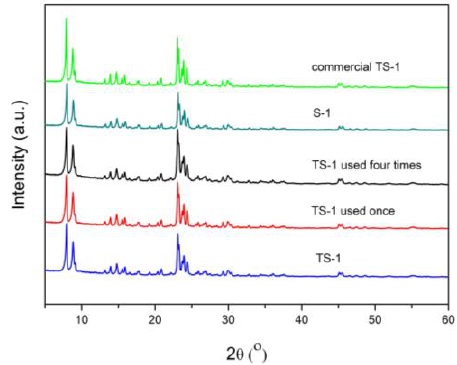
Figure 5. XRD patterns of TS-1, used TS-1, S-1, and commercial TS-1.